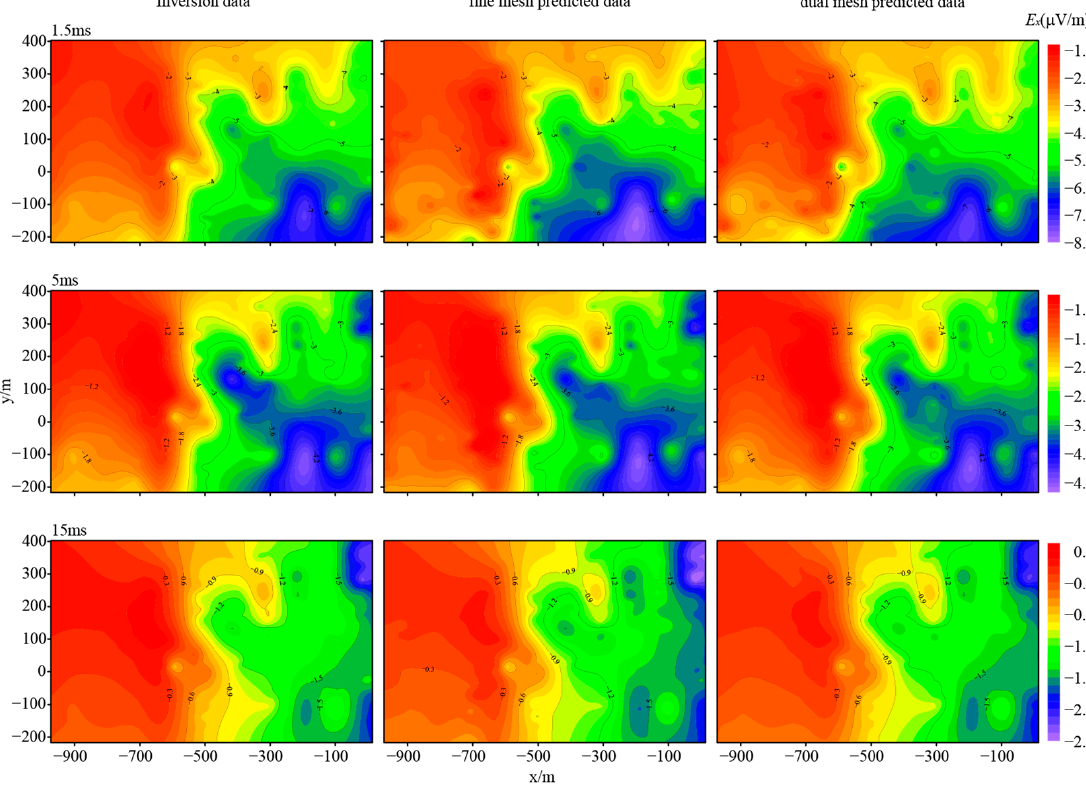
Figure 12. Data fi tt ing at the earth surface for dual-mesh and conventional methods. Figure 12. Data fitting at the earth surface for dual-mesh and conventional